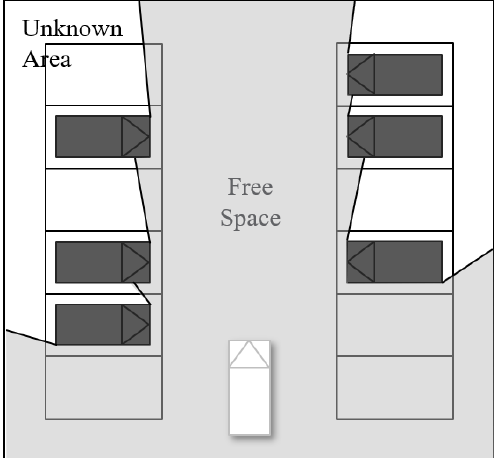
Figure 2. Area classified by the occlusion